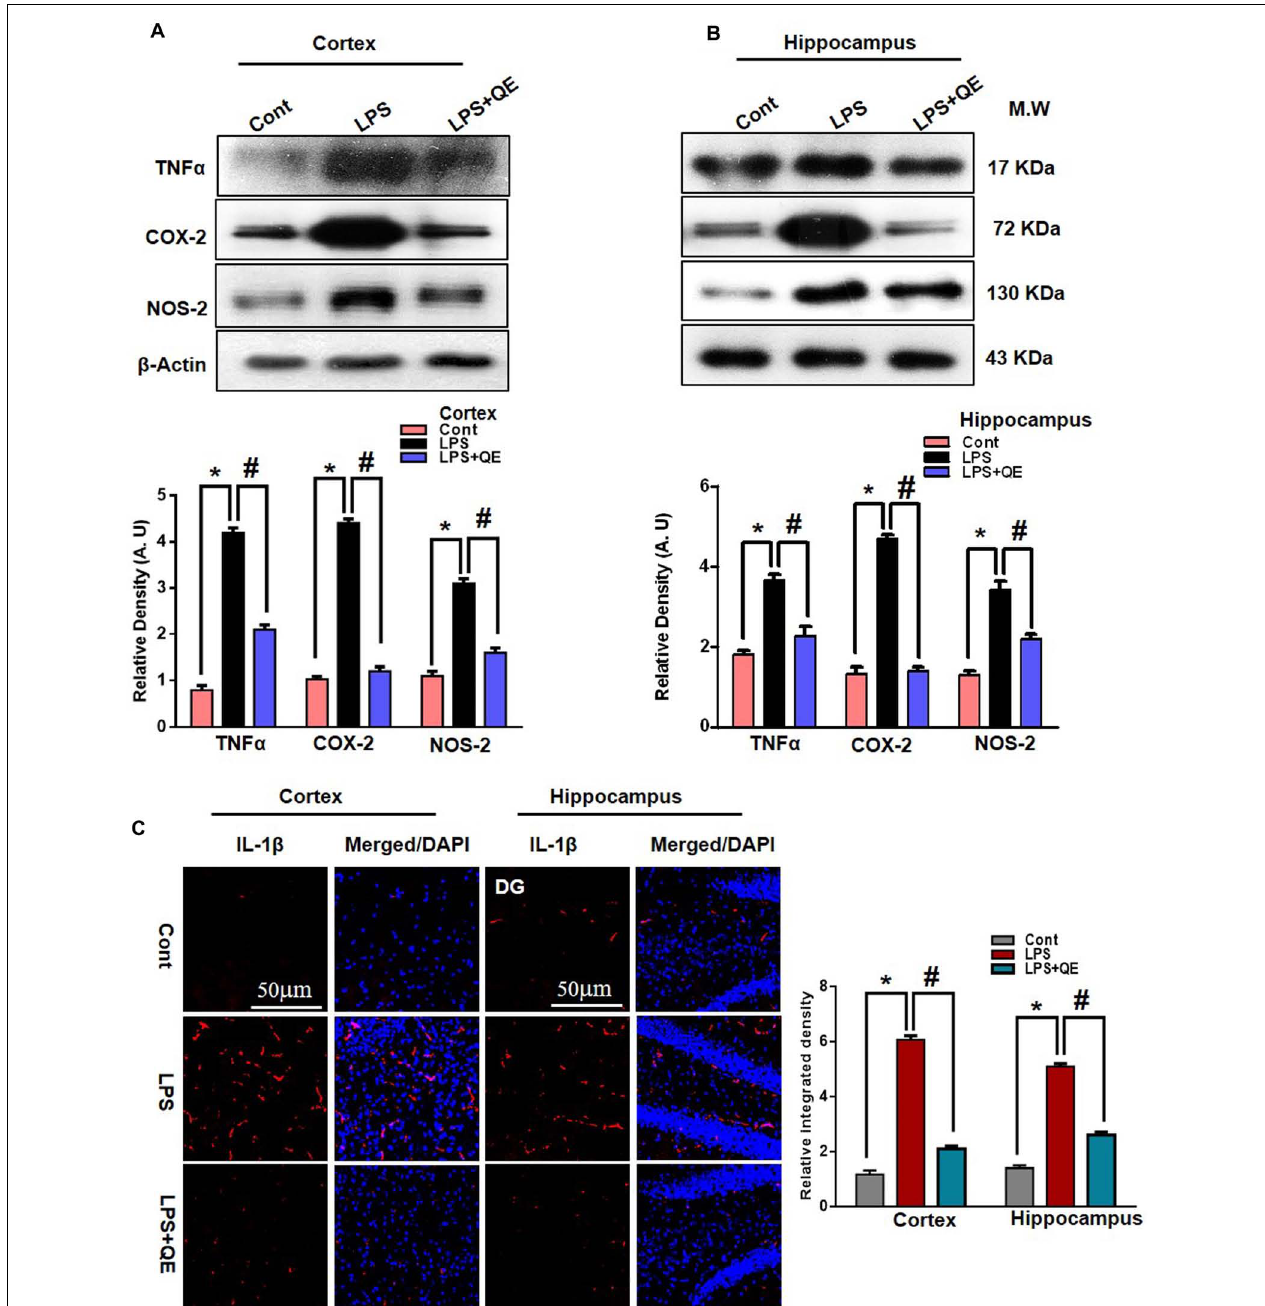
FIGURE 6 | Quercetin attenuated LPS-induced neuroinflammation-associated markers. (A,B) Western blotting of TNF- α , COX-2 and NOS2 proteins; their differences in the cortex and hippocampus of mouse brains are represented by a histogram. β -Actin was used as a loading control. The quantified density values are shown in arbitrary units (A.U.) as the means ± SEM for the respective shown protein (8 mice/group). (C) Representative immunofluorescence images and the quantified histogram of IL-1 β in the cortex and hippocampus of adult mice (5 mice/group). Magnified 10 × . Scale bar = 50 µ m. The expressed data are relative to the control. ∗ Significantly different from the control; # significantly different from LPS-treated group. Significance: P <